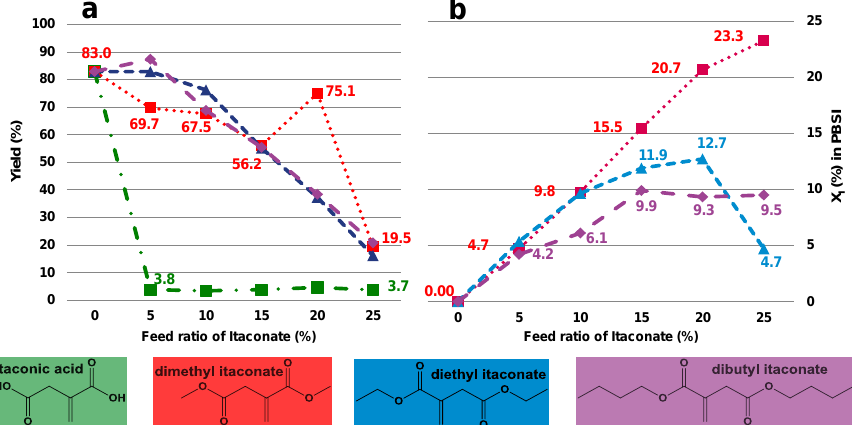
Figure 4. The effect of itaconate structure on CALB-catalyzed synthesis of PBSI: ( a ) the reaction yield of PBSI as a function of the feed ratio of itaconate; ( b ) the mole percentage of itaconate in PBSI (X ) as a function of the feed ratio of I